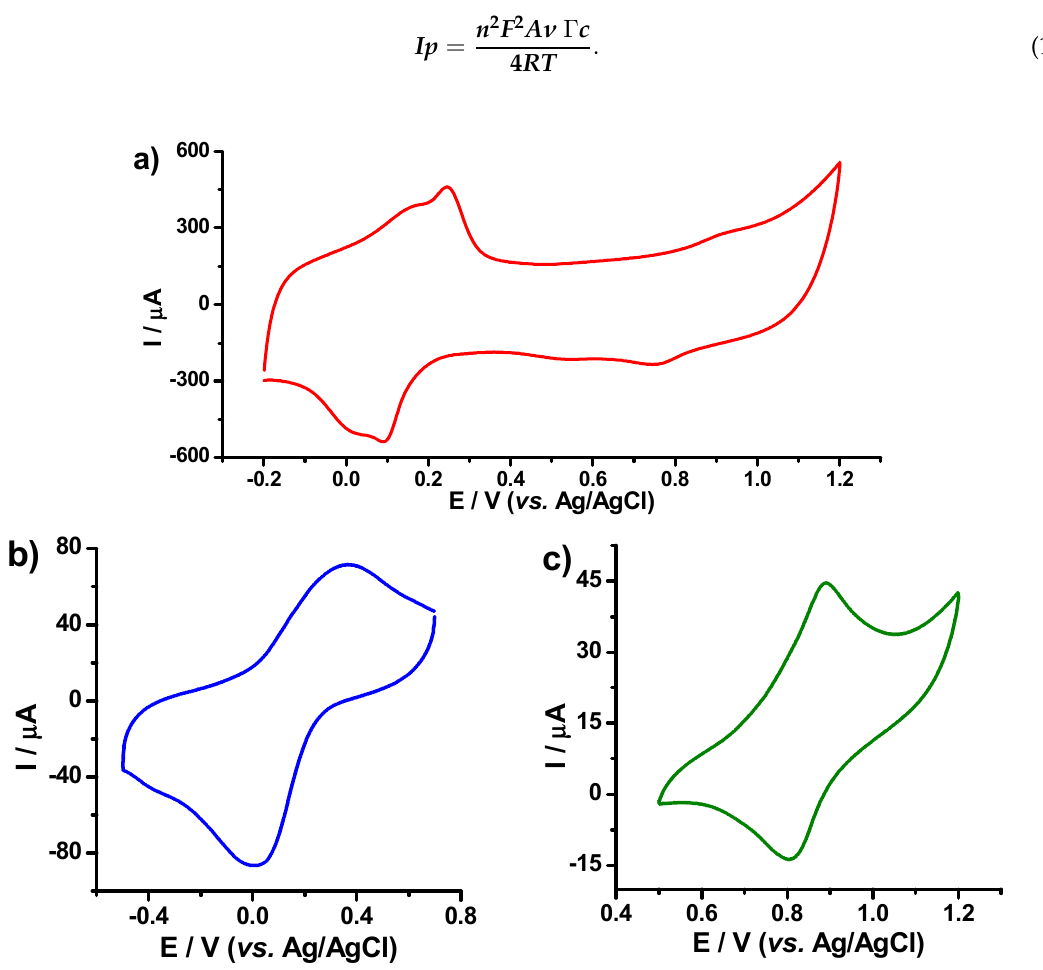
Figure 7. Cyclic voltammetry of the modified electrodes in 0.1 mol · L − 1 phosphate-buffered solution at pH 7 at a scan rate of 100 mV / s: ( a ) PB–fCNT / GC; ( b ) PB–TiO 2 / fCNT / GC reduction zone; ( c ) PB–TiO 2 / fCNT / GC oxidation zone. The average value of Г c for the redox peaks was 4.98 × 10 PB–fCNT / GC and PB–TiO 2 / fCNT / GC modified electrodes, respectively (for n = 4 and v < 1000 mV · s